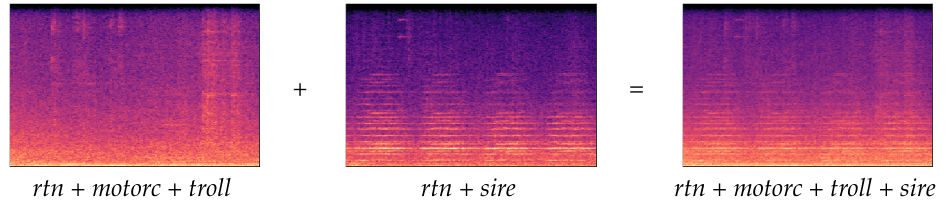
Figure 4. Example of mixup data augmentation using two random 4-s fragments containing several acoustic